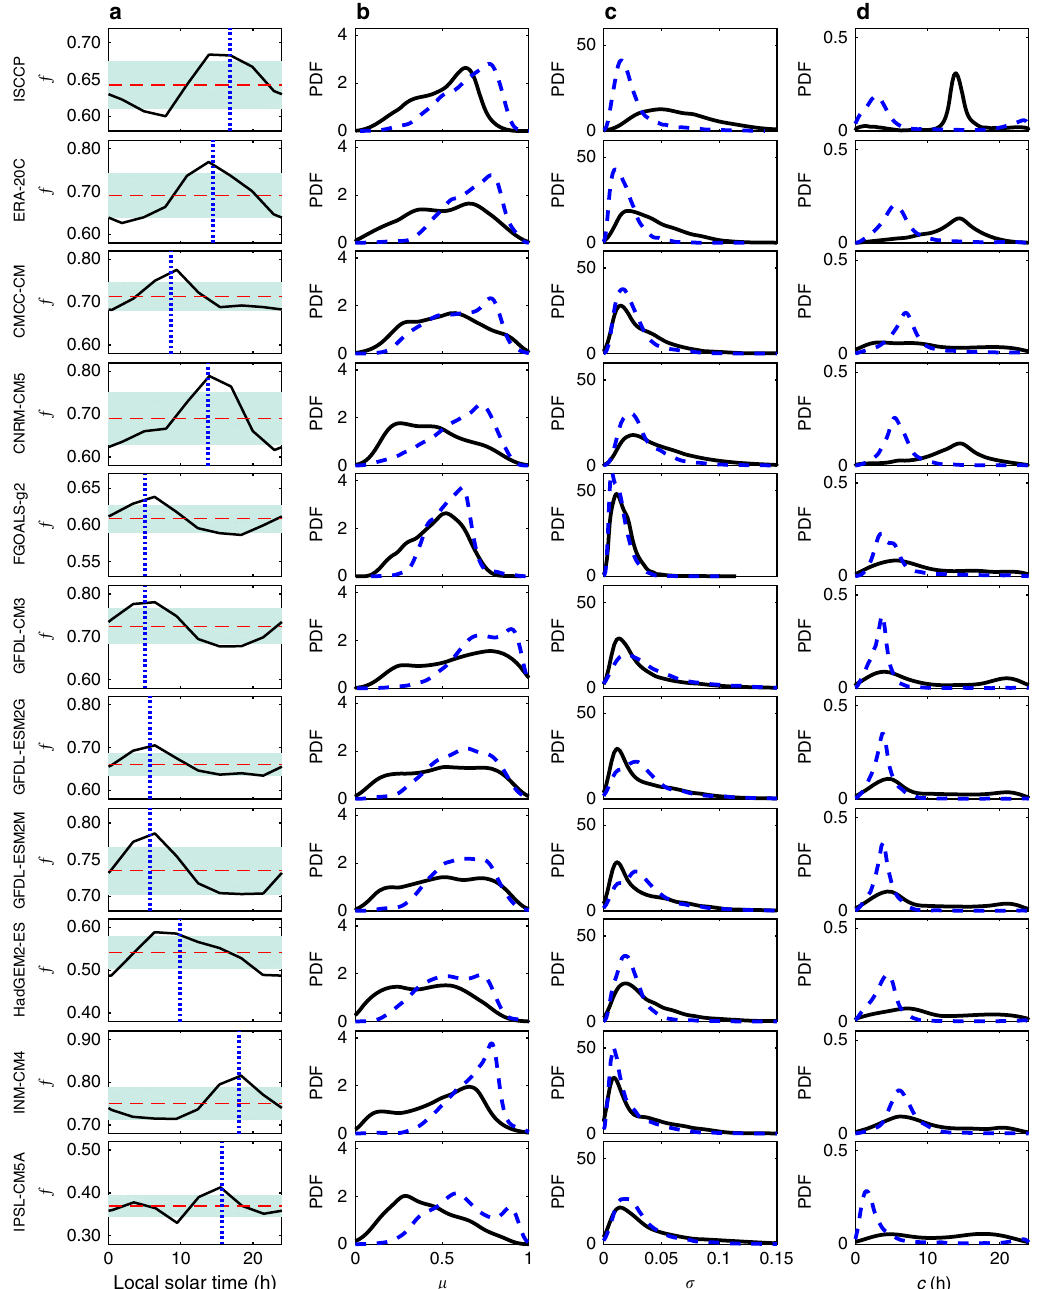
Fig. 1 Diurnal cycle of cloud climatology and its indexes. a Examples of diurnal cycle of average cloud coverage near Guangde, Anhui, China (30.7N, 119.2E) in summer (June, July, and August) averaged over 1986 – 2005. The vertical dot lines and horizontal dash lines show the centroid and mean of the diurnal cycle climatology; the shaded blue areas indicate plus and minus one standard deviation. More examples are presented in Supplementary Fig. 2. Empirical probability density function (PDF) of b mean ( μ ), c standard deviation ( σ ), and d centroid ( c ) of diurnal cycle of cloud coverage climatology over the land (black solid lines) and ocean (blue dash lines) in all four seasons over 60S – 60N. The data sources (satellite observations, reanalysis, and climate models) are indicated on the left side of the fi gure (see Supplementary Table 1 for a list of